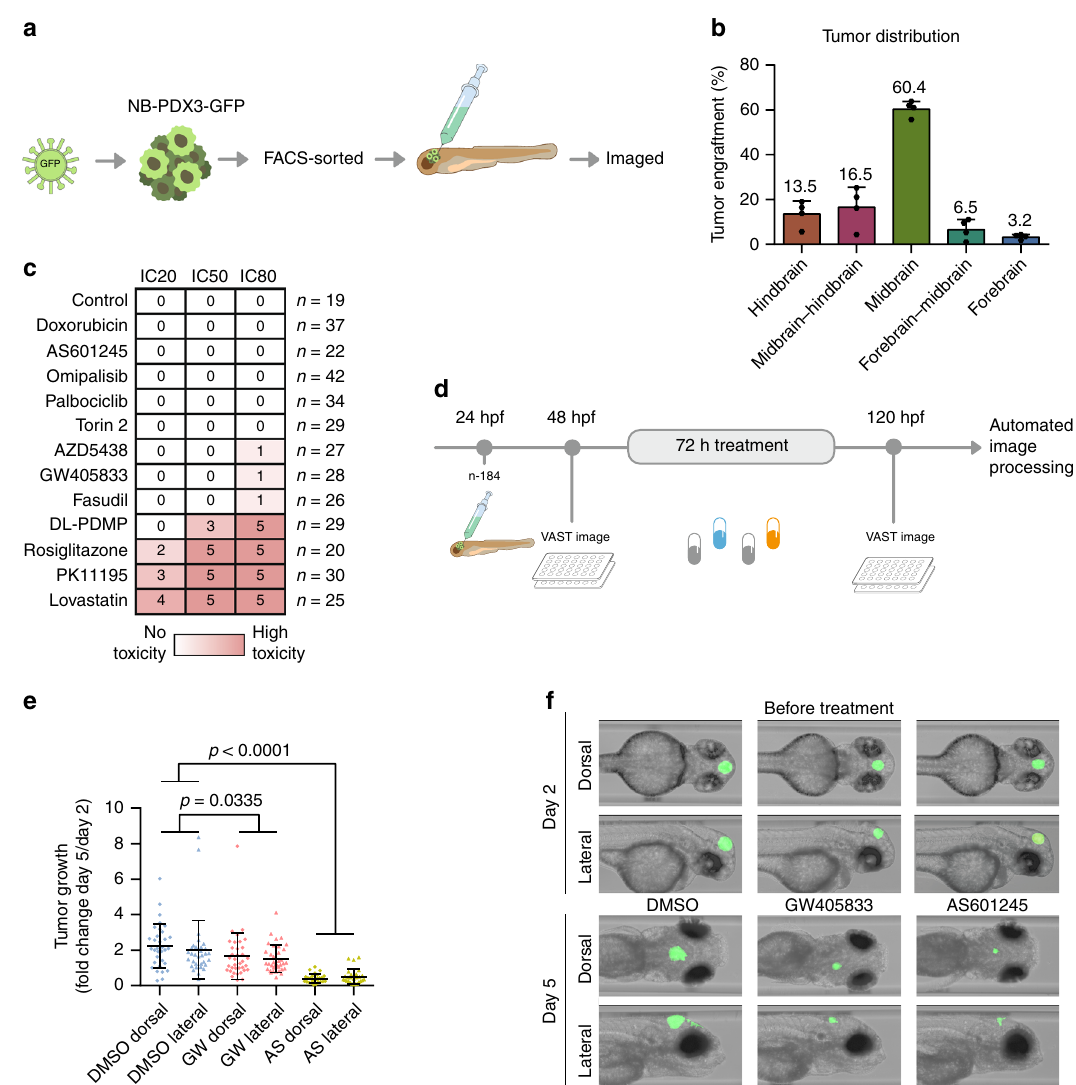
Fig. 6 Targeting MAPK8 and CNR2 suppressed neuroblastoma xenografts in zebra fi sh. a Work fl ow: patient-derived neuroblastoma cells were tagged with green fl uorescent protein (GFP), sorted, and injected into the midbrain of 1-day post fertilization (dpf) zebra fi sh embryos. b Tumour localization 24 h following injection ( n = 266) (mean, standard deviation). c 2 dpf zebra fi sh embryos were exposed to drug concentrations corresponding to IC20, IC50 or IC80. Toxicity was noted after 24h , and score between 0 (no toxicity, white) and 5 (instant, lethal toxicity, red). d Automated image-based assay of tumour growth in xenotransplanted zebra fi sh embryos. e Tumour area increase from 2 to 5 dpf (mean, standard deviation). f Representative image of the same zebra fi sh embryos before and after